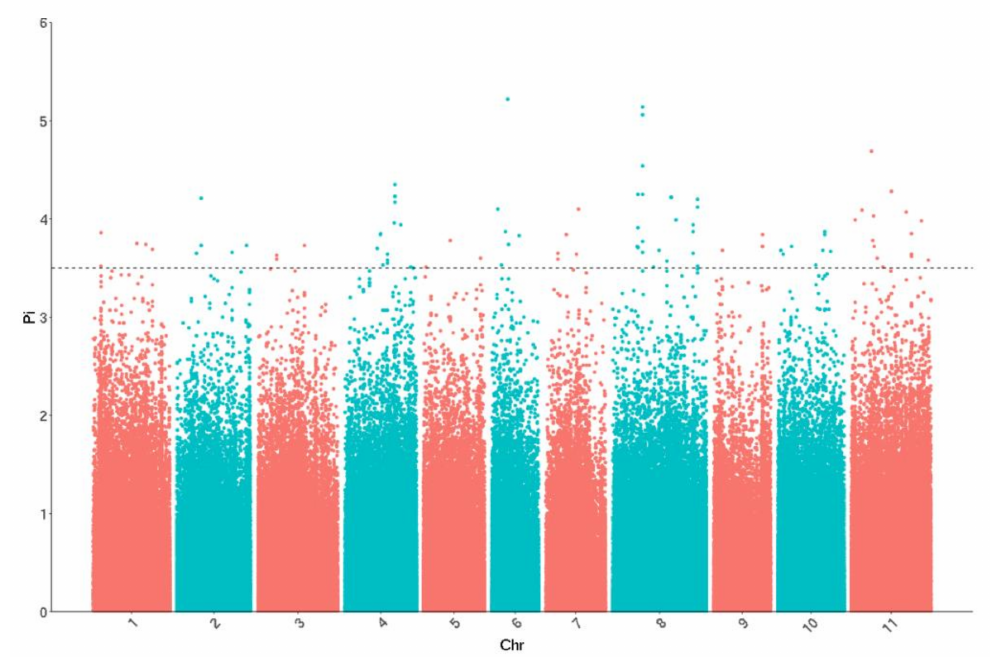
Figure 4. Manhattan plots for rust resistance in current study. Pi, − log10 ( p